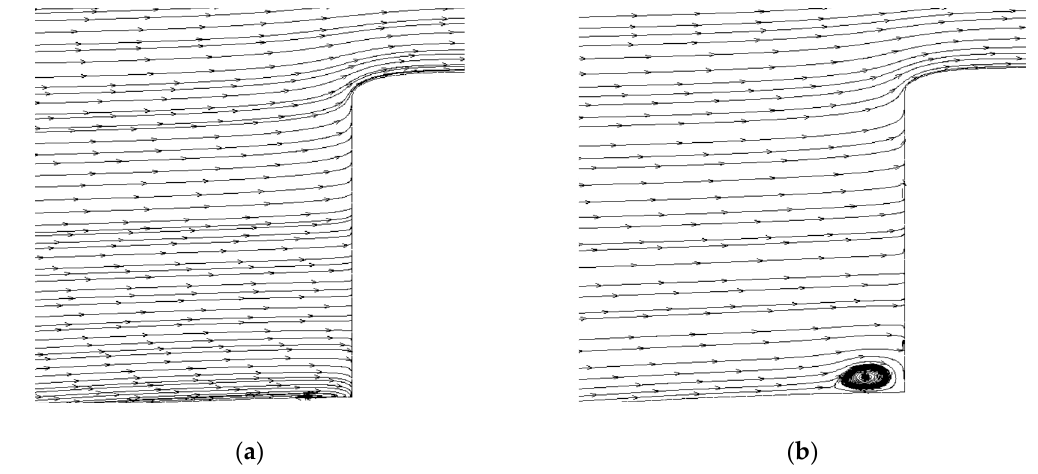
Figure 14. The streamline near the leading edge of Plane B between the original model and the model with triangular VGs. ( a ) The original model; ( b ) the model with triangular VGs.